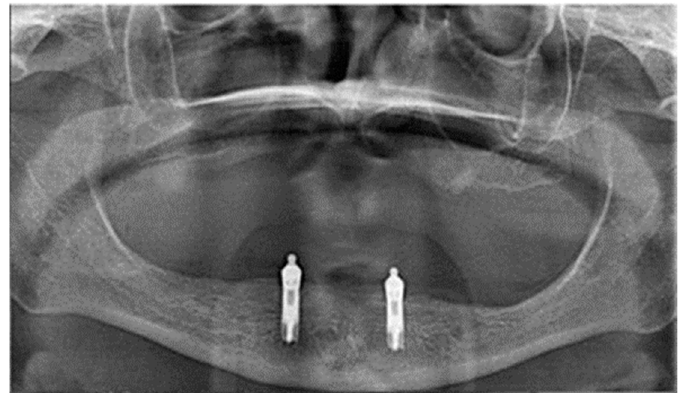
Figure 4. Panoramic X-ray. Post-operative, 60 months’ follow-up .